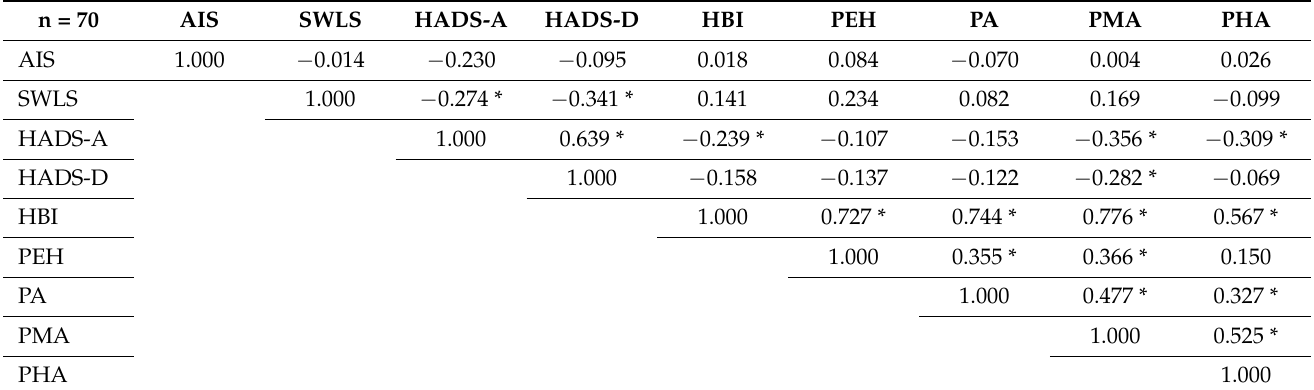
Table 4. Associations between life satisfaction, illness acceptance, health behaviors and severity of anxiety and depression symptoms in a group of people with anxiety